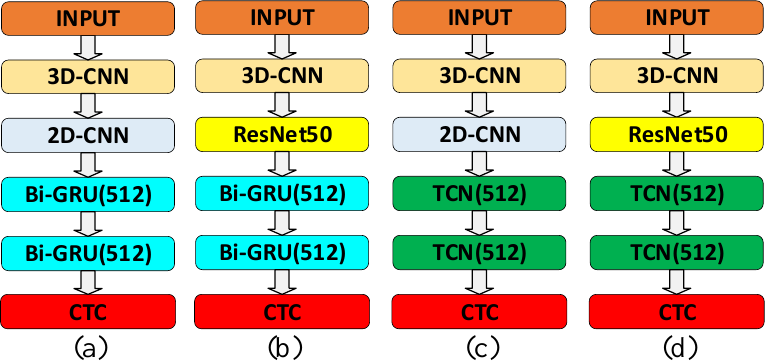
Figure 6. Diagrams of ablation experiments with different architectures. ( a ) 3D-2D-CNN-BGRU-CTC, ( b ) 3D-ResNet50-BGRU-CTC, ( c ) 3D-2D-CNN-TCN-CTC, ( d )